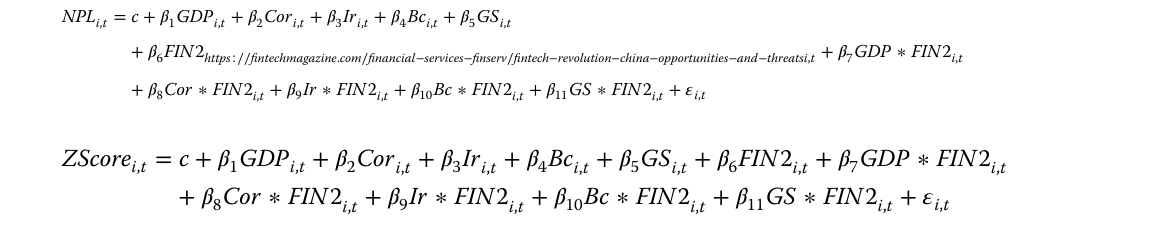
Table 1 The Phase of Fintech Evolution from the Study of Arner in [8] Fintech Progression Evolution